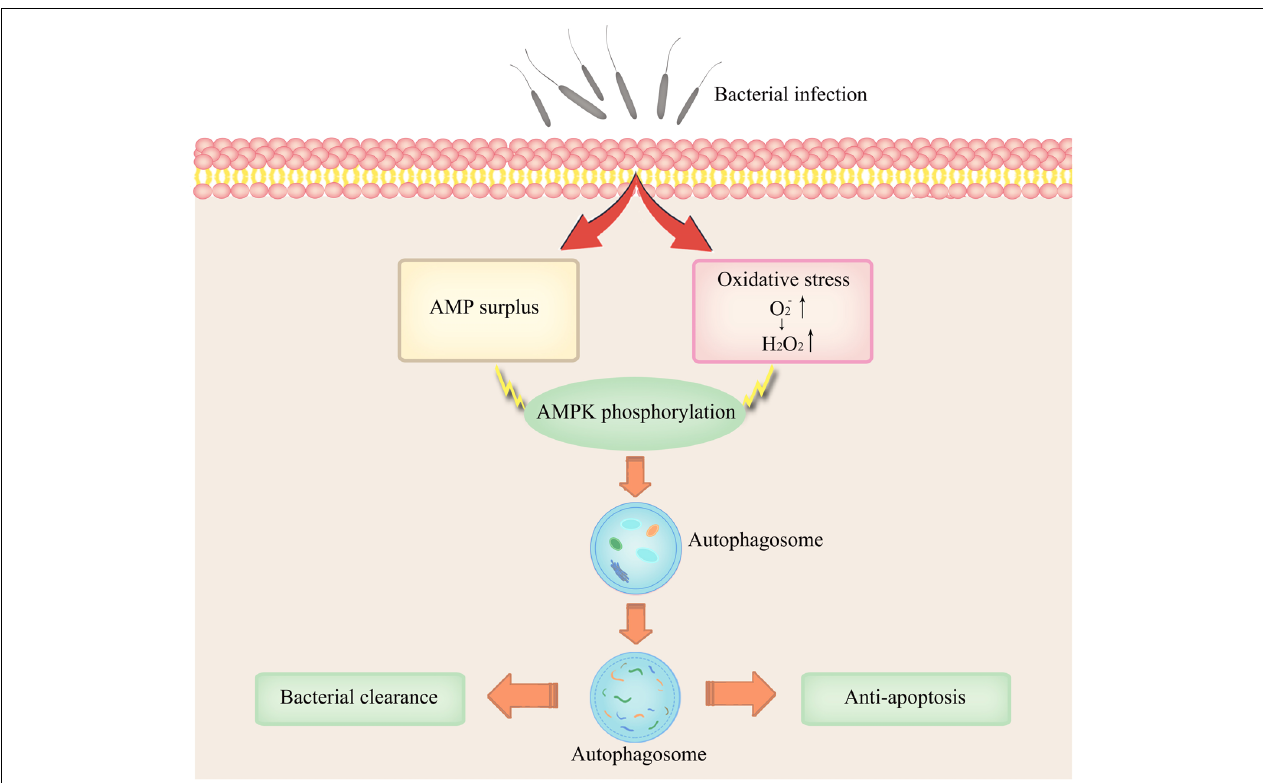
FIGURE 6 | Conceptual representation of the links between AMPK activation and infection-induced autophagy synergistically induced by AMP and